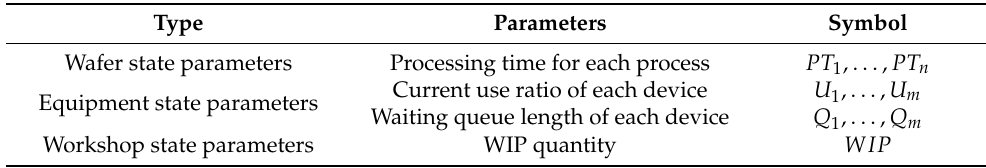
Table 1. Influencing parameters of the cycle